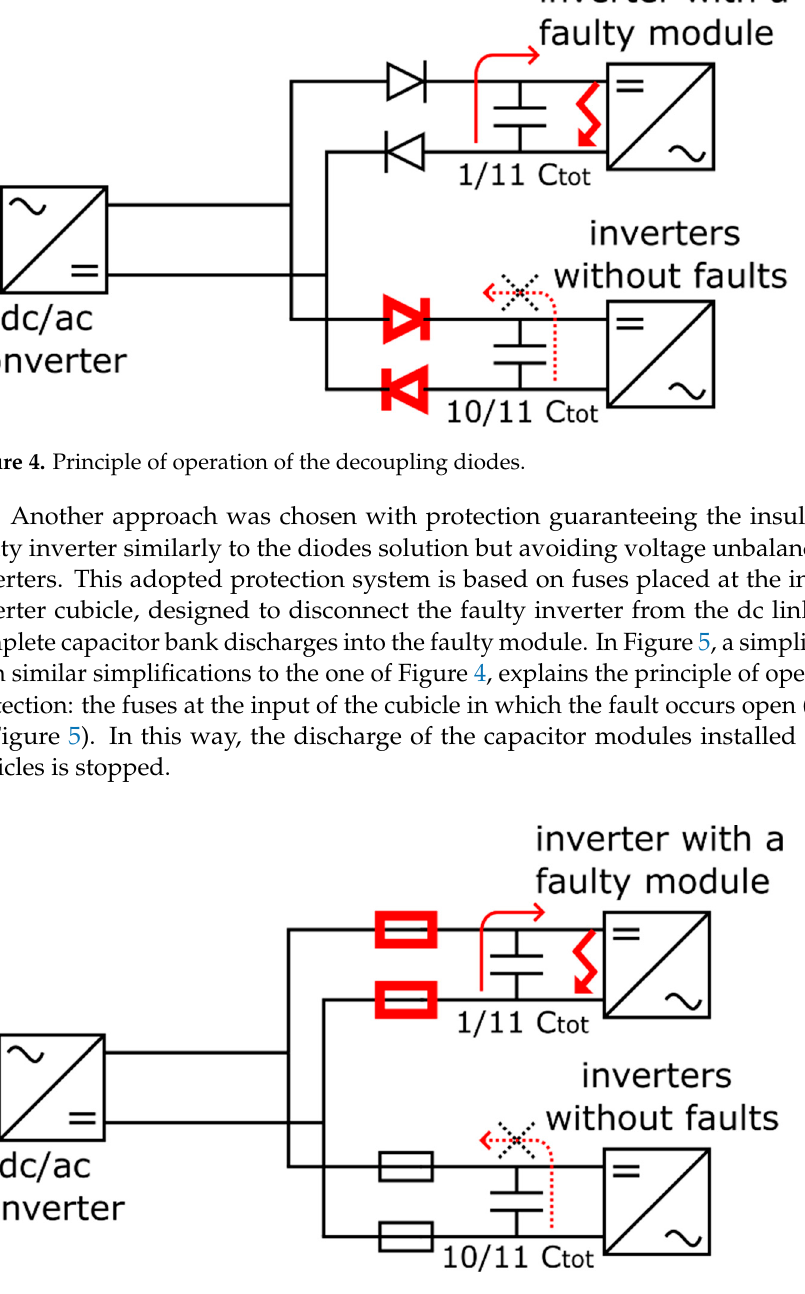
Figure 3. Electrical scheme of one inverter module.